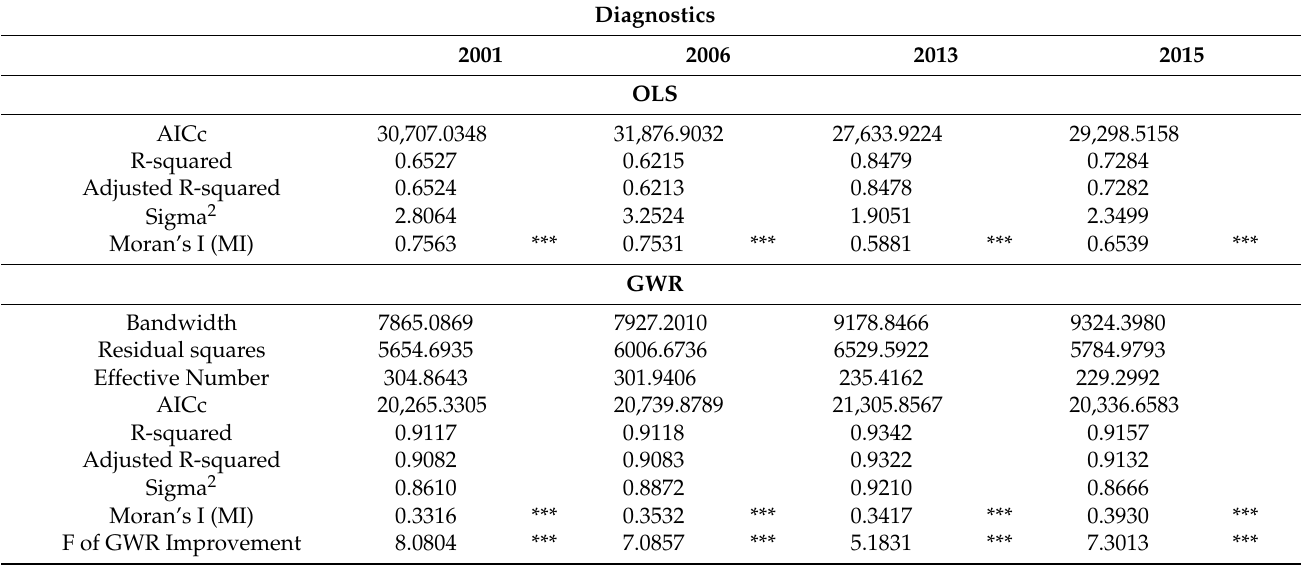
Table 5. Results and diagnostics of OLS and GWR analysis. AICc, corrected Akaike information